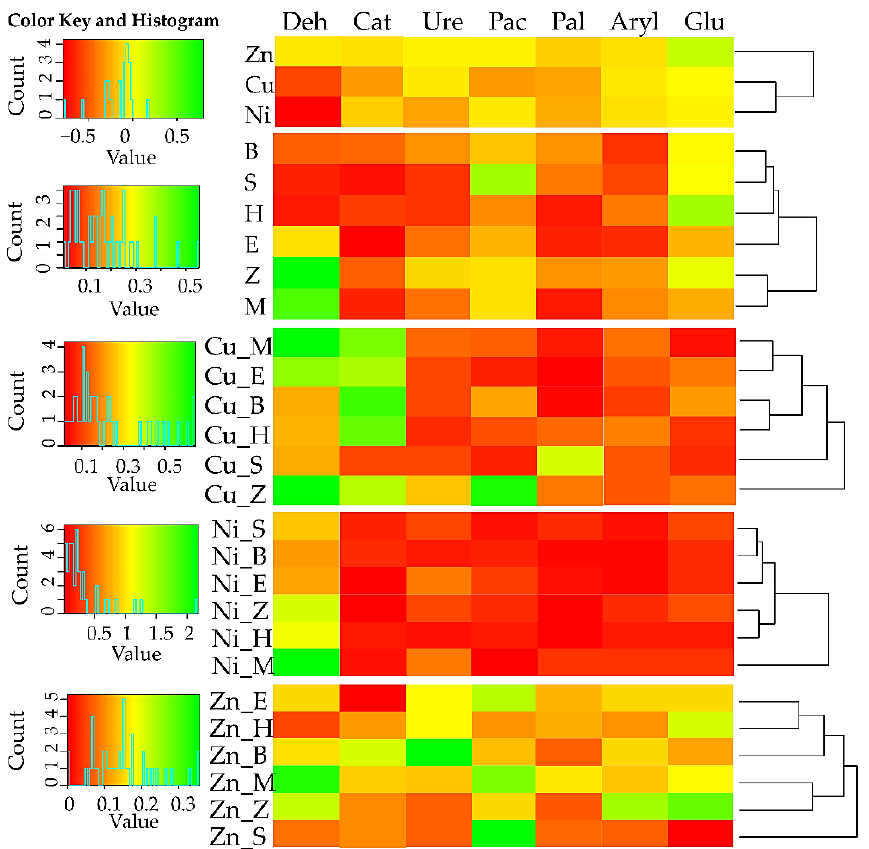
Figure 4. Index of the influence of heavy metals and sorbents on the activity of soil enzymes. The abbreviations are explained under Figure 1.